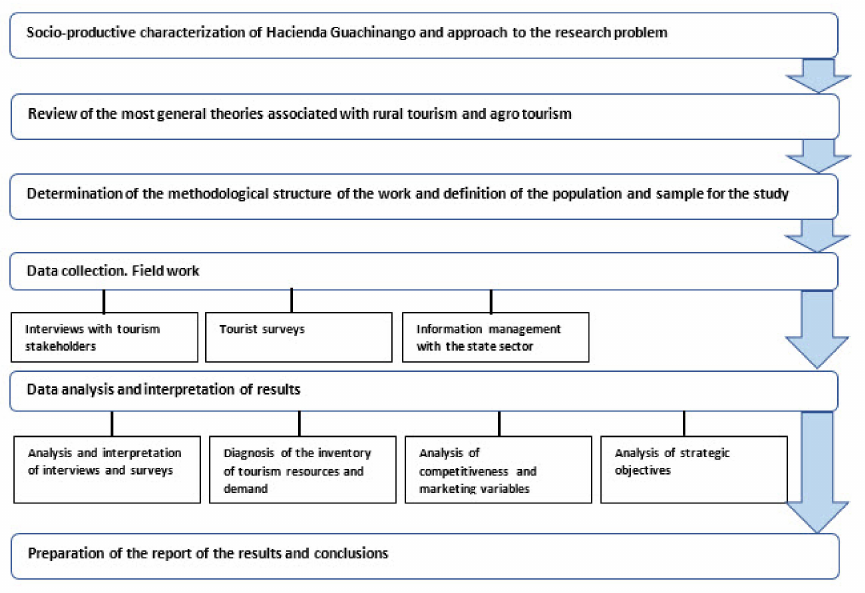
Figure 2. Diagram of the research methodology. Source: own elaboration based on